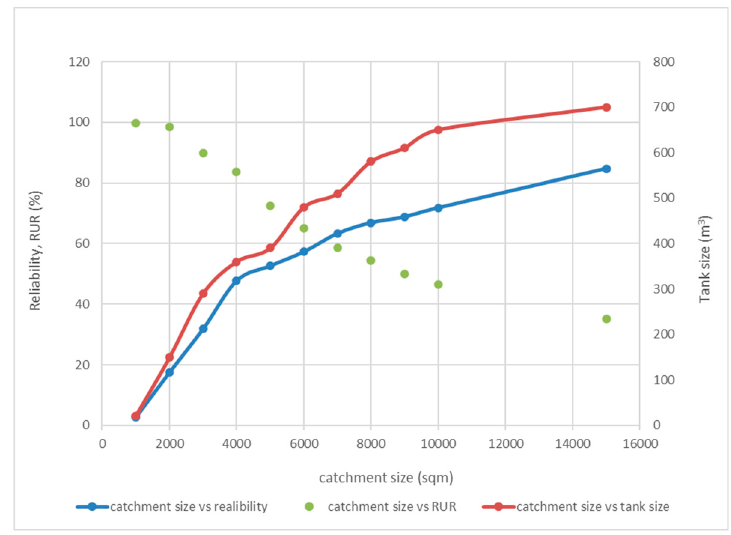
Figure 6. Effects of catchment area variations on harvested rainwater storage and reliability in hotel industry.